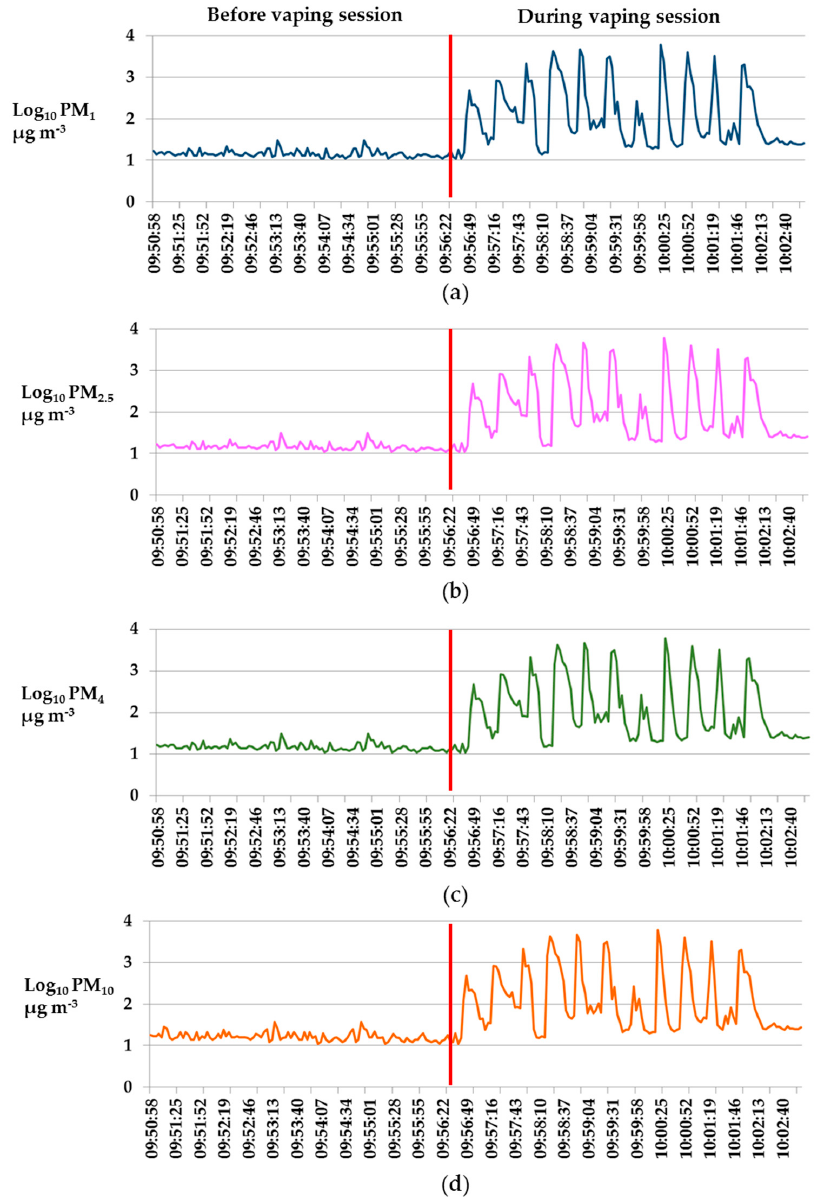
Figure 1. Levels of particulate matter with an aerodynamic diameter smaller than 1 (PM 1 ) (a), 2.5 (PM 2.5 ) ( b ), 4 (PM 4 ) ( c ), and 10 µ m (PM 10 ) ( d ) (values expressed as Log 10 ) measured before and during the vaping session of an Iqos1. Red line divided the concentrations measured before and those measured during the vaping session.